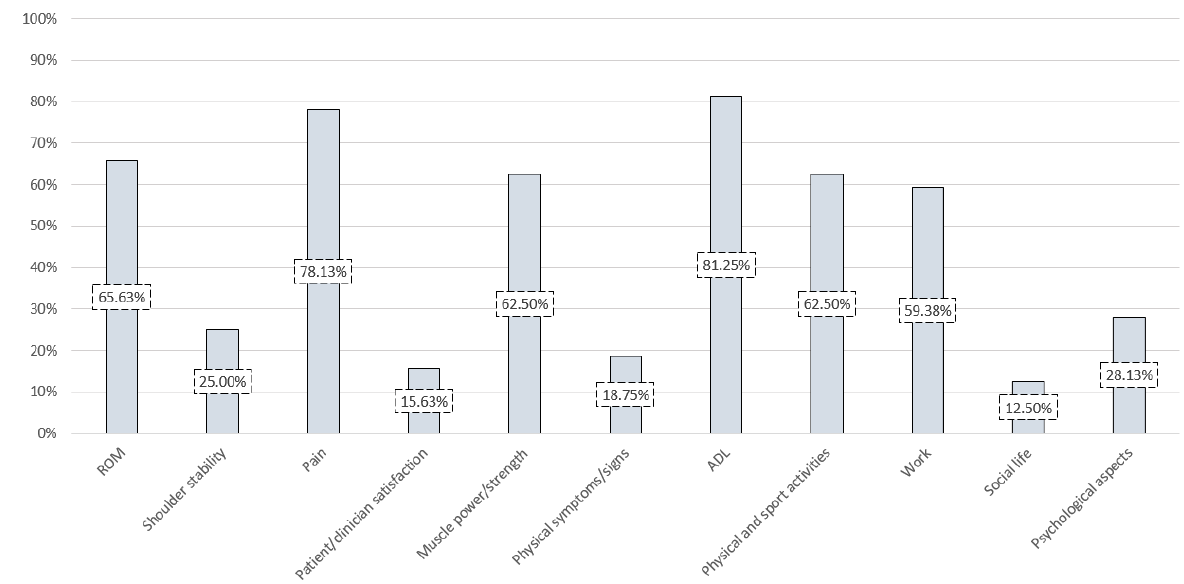
Figure 2. Frequency with which the scales consider specific topics. Abbreviations: ADL, activities of daily living; ROM, range of motion.